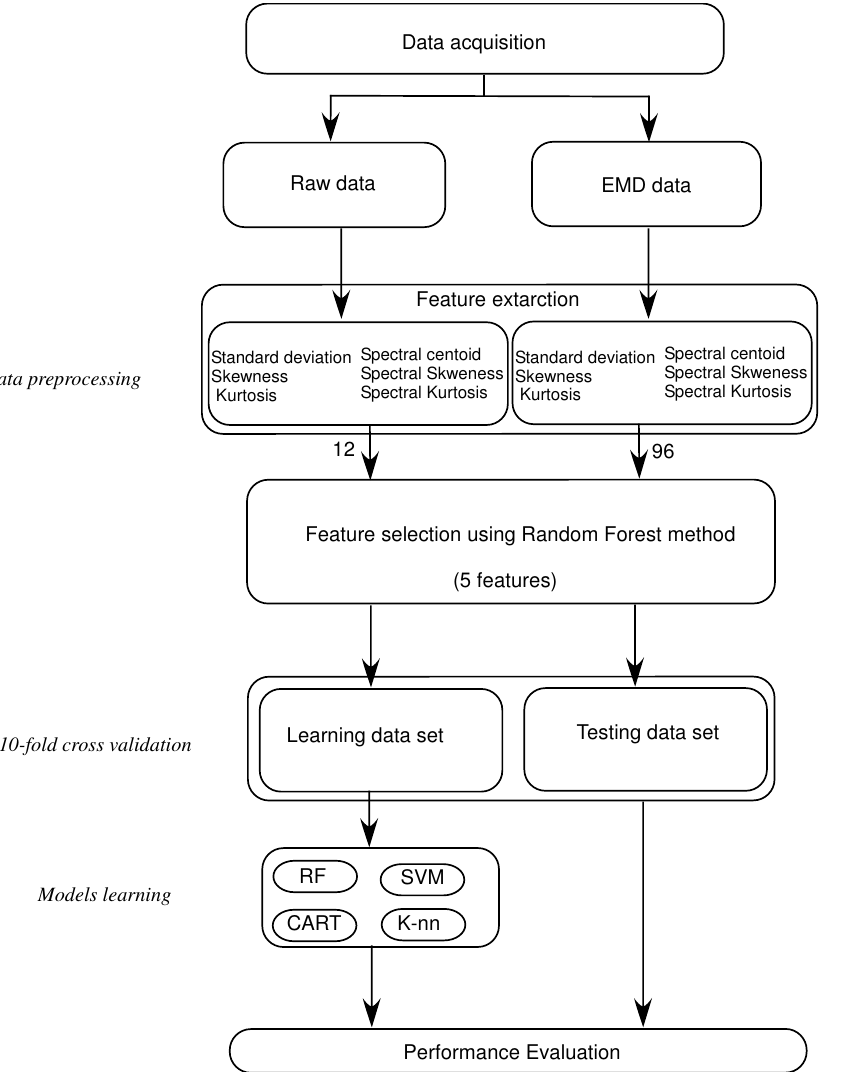
Figure 2. Healthy and PD patient classification